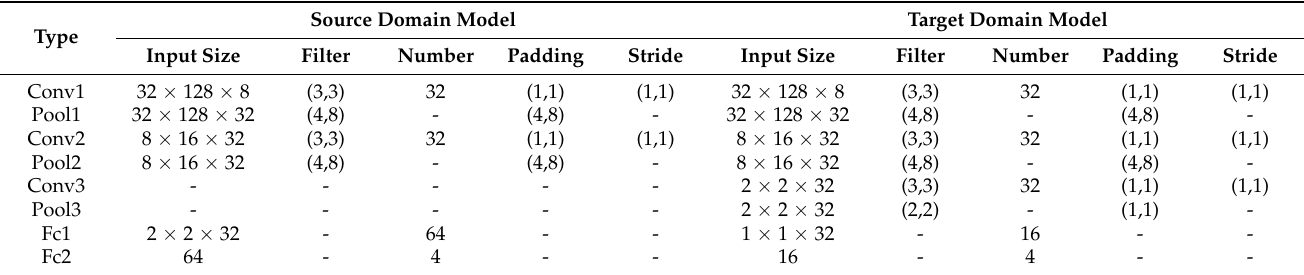
Table 2. Source domain model and target domain preliminary model network structure.